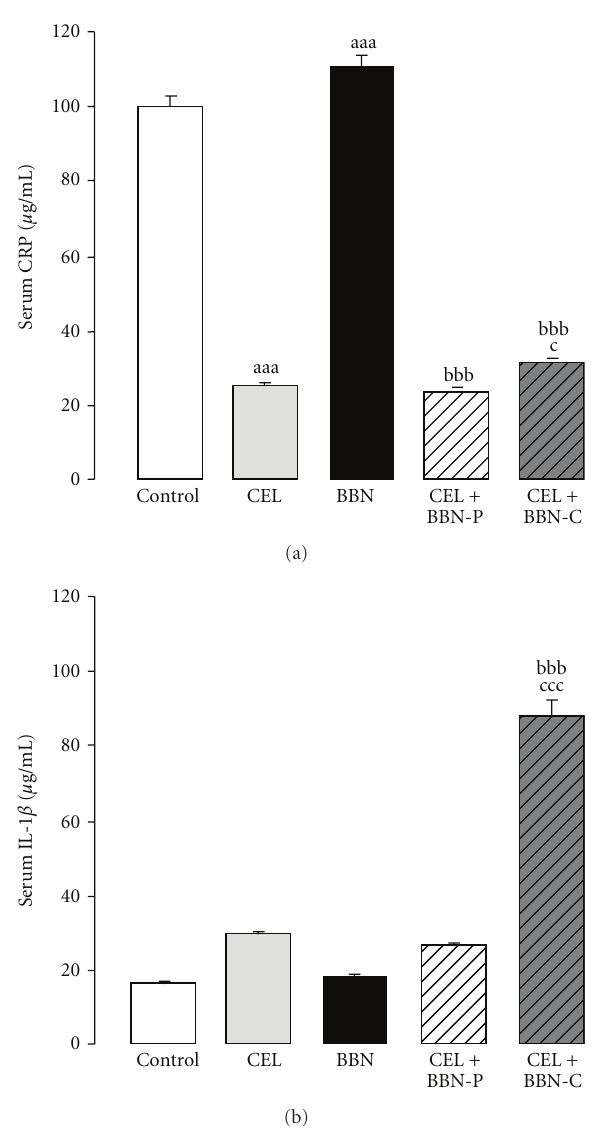
Figure 3: Serum markers of inflammation: C-Reactive Protein (a) and Interleukin-1 β (IL-1 β )—in the five groups under study. Values are mean ± SEM. aaa - P < . 001 versus the control group; bbb - P < . 001 versus the BBN group and c - P < . 05 and ccc - P < . 001 versus the CEL+BBN-P